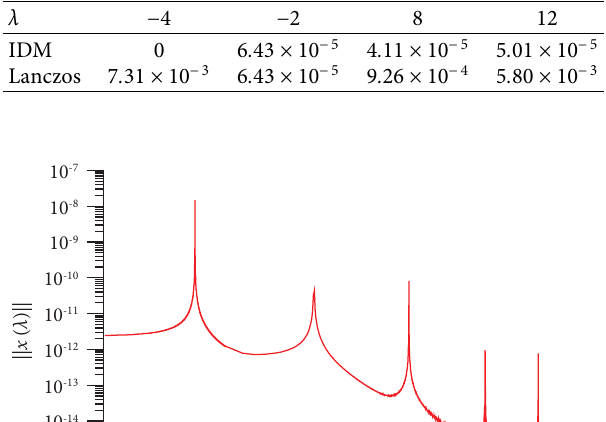
Figure 12: For Example 10, showing four picks of ‖ x ‖ , corre- sponding to eigenvalues − 4, − 2, 8, and 12. Table 5: For example 10 solved by the IDM and the Lanczos al- gorithm, comparing the errors of eigenvalues.